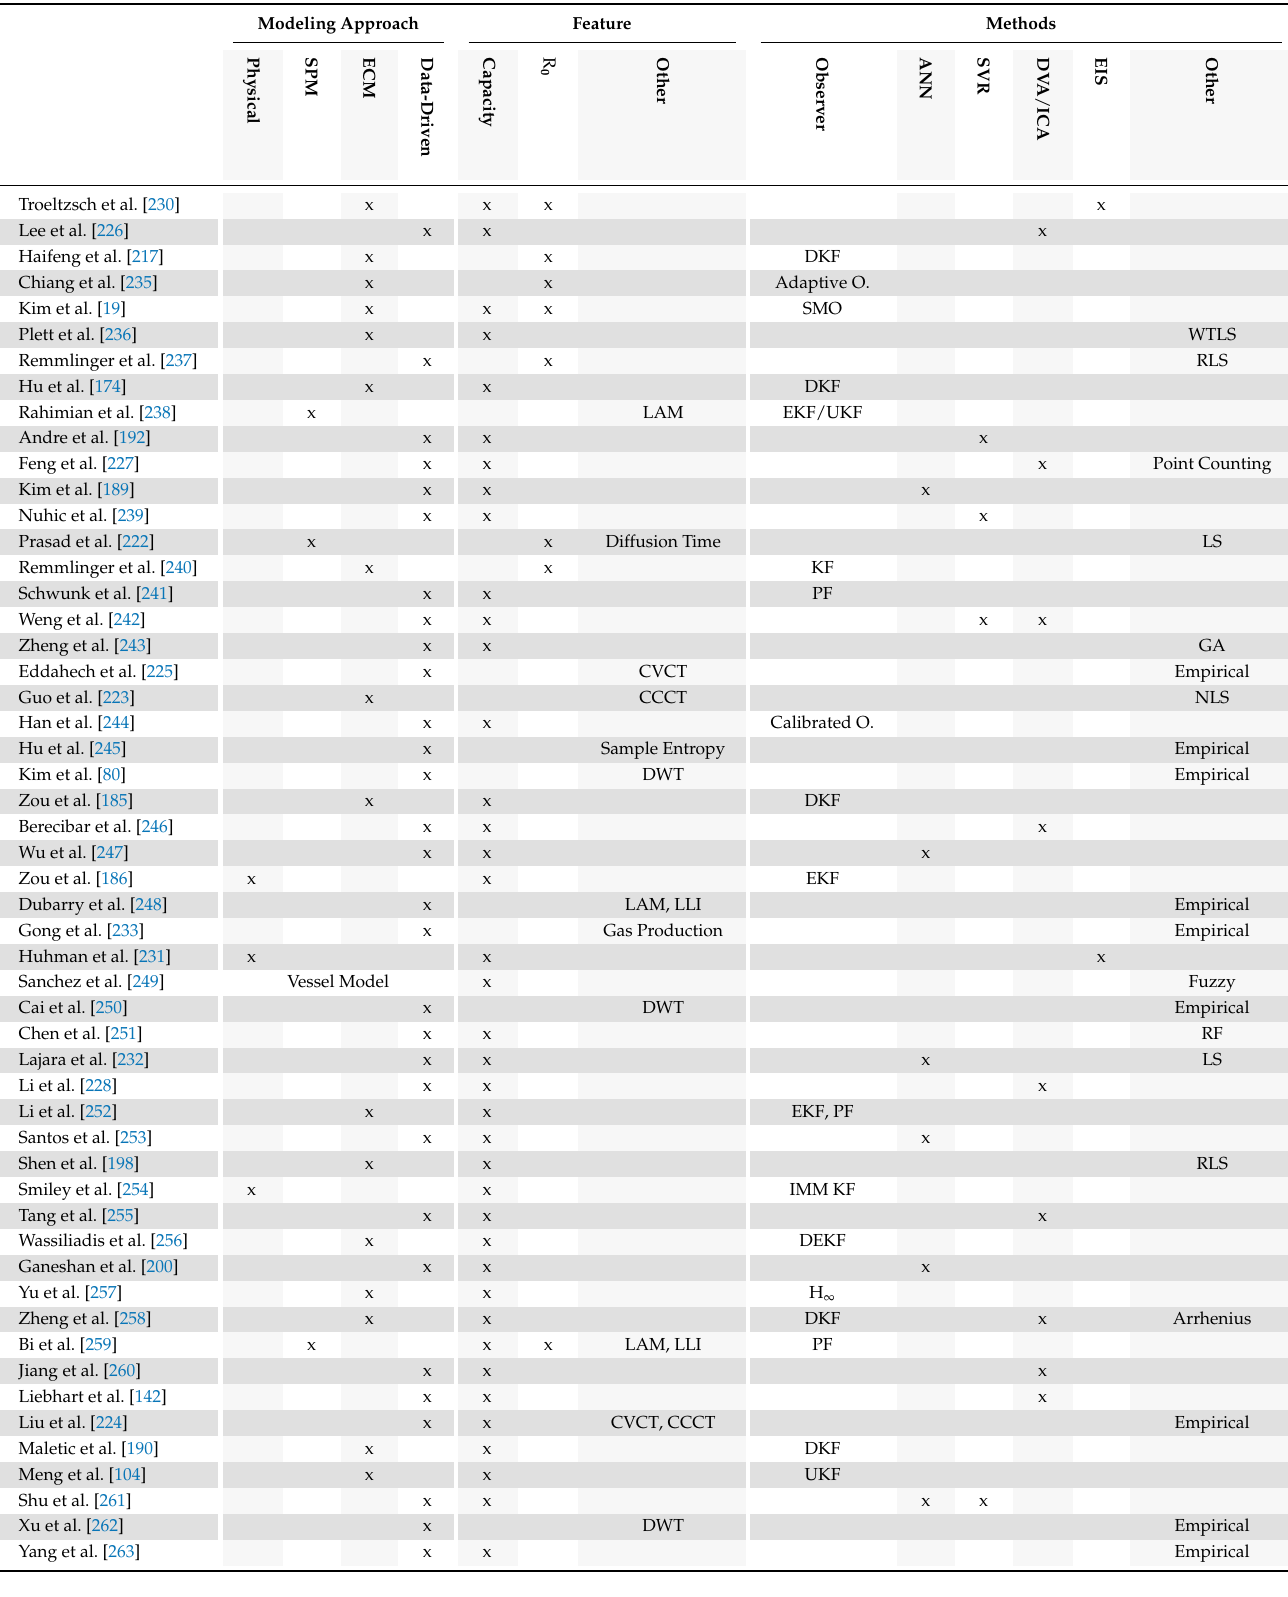
Table 4. Online SOH identification approaches in chronological order. Abbreviations: Discrete Wavelet Transform (DWT), Level Shifted